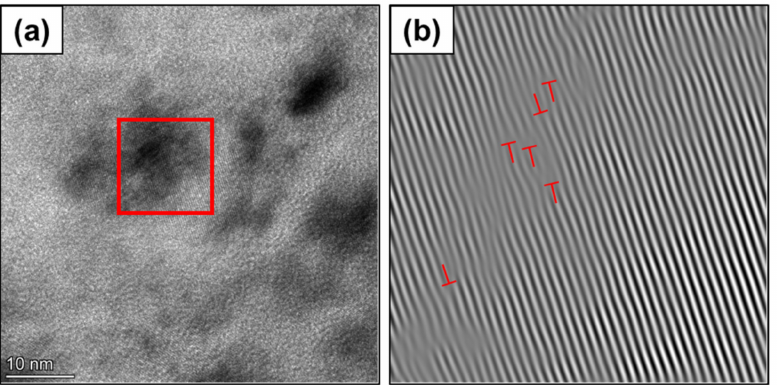
Figure 6. The interaction between the dislocations and the element segregation in the 945A-32h sample, ( a ) the high-resolution TEM image, ( b ) the inverse FFT of the red box in the Figure